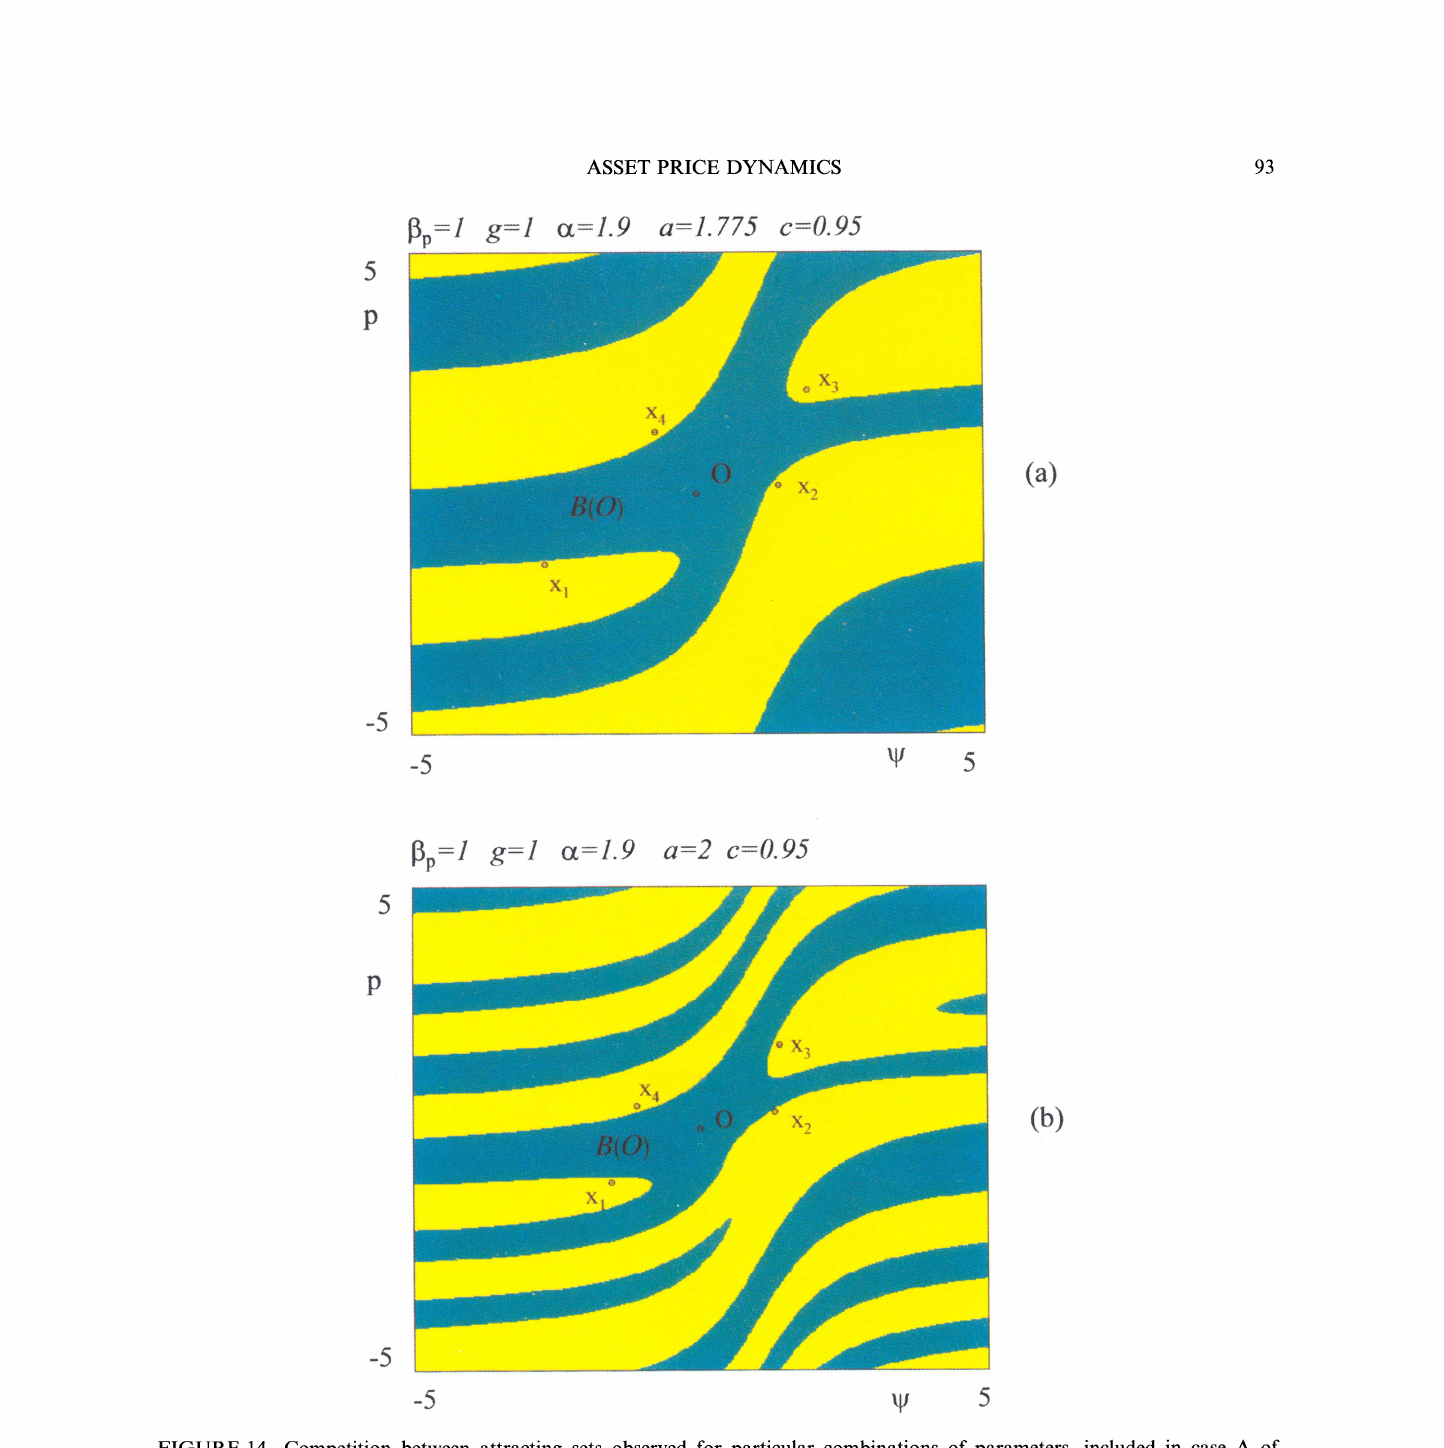
FIGURE 14 Competition between attracting sets observed for particular combinations of parameters, included in case A of Figure 1. For e 0.95,/3p 1, g 1, c 1.9, and increasing a starting from low values inside the stability region, the origin O is initially the only attracting set, but as a is increased a saddle-node bifurcation is observed. In (a), where a 1.775, and in (b), where a 2, there is coexistence of the stable fixed point O and a stable 4-cycle C4. (See Color Plate